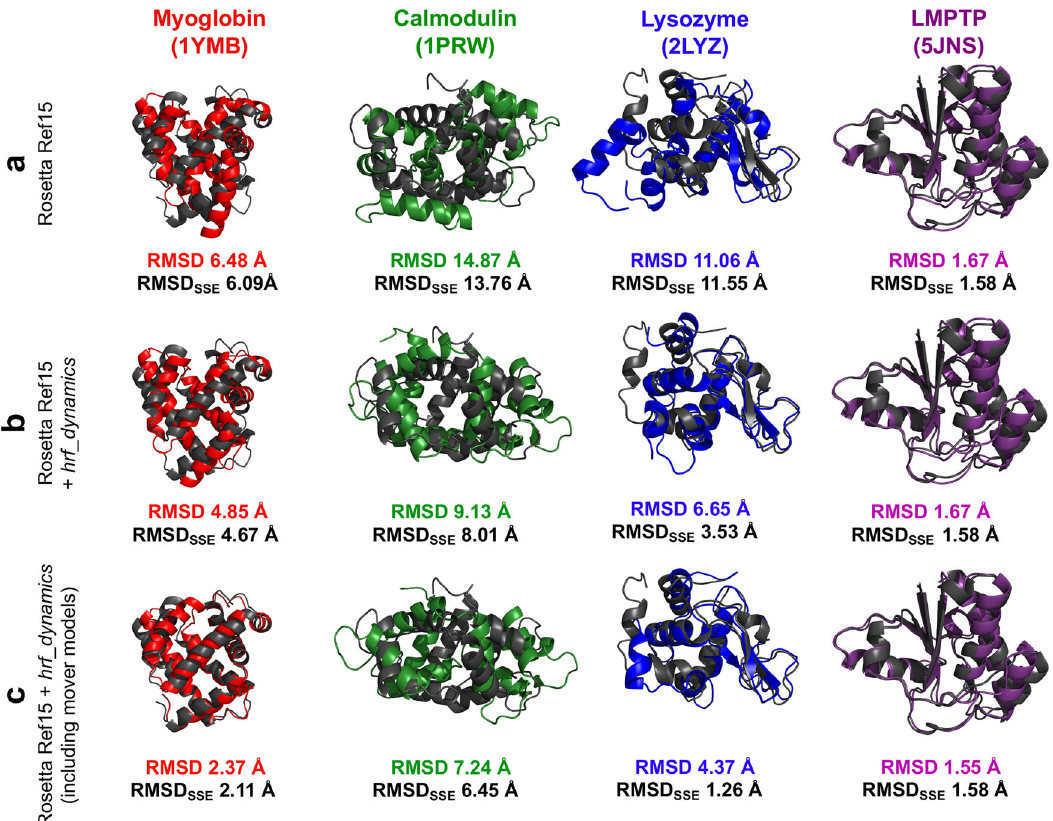
Fig. 3 Crystal structures (dark gray) of benchmark proteins aligned with best scoring model predictions (color). RMSD and RMSD over SSEs (RMSD SSE ) are listed. Structure visualization was accomplished in PyMOL. Myoglobin models are shown in red, calmodulin in green, lysozyme in blue, and LMPTP in purple. a Best scoring model based on scoring with Rosetta Ref15. b Best scoring model based on scoring with Rosetta Ref15 + hrf_dynamics . c Best scoring model including mover models scored with Rosetta Ref15 + hrf_dynamics